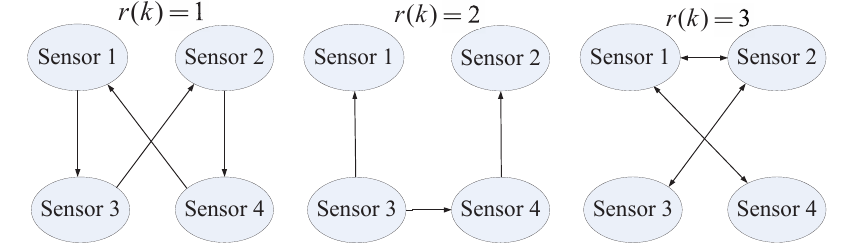
Figure 2. Filtering network